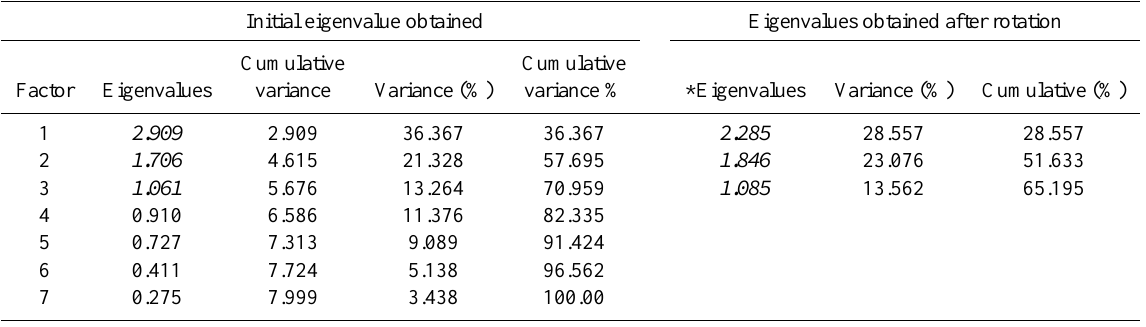
Table 3. Eigenvalues of the correlation matrices explained by the various factors. Initial eigenvalue obtained Eigenvalues obtained after rotation Cumulative Cumulative